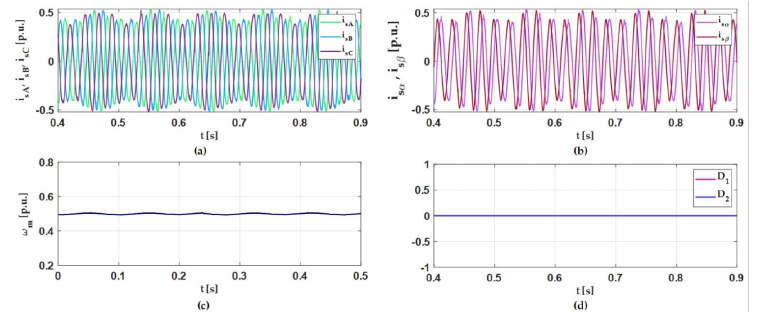
Figure 19. Transients of basic variables: phase currents ( a ), current components α , β ( b ), speed ( c ), detector responses ( d ) under healthy conditions on experimental